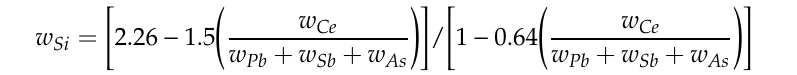
Figure 39. Growth of spheroidal, intermediate and chunky graphite forms; reproduced from [131] adapted after [48] with permission from Springer.